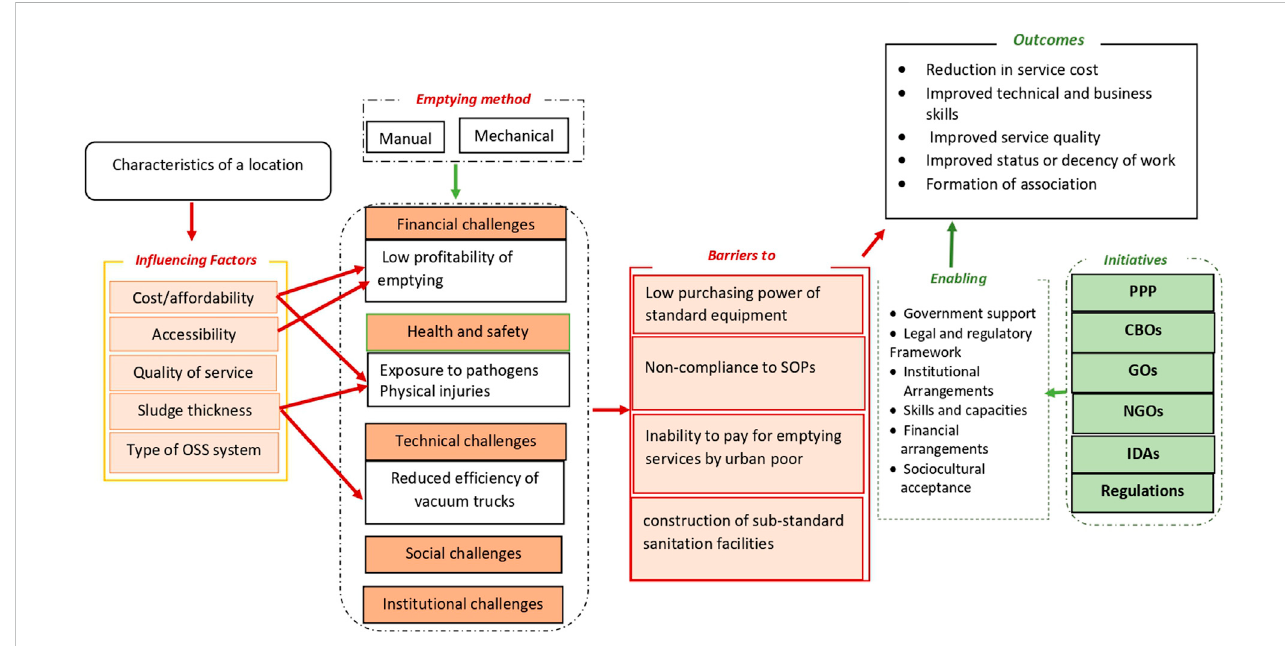
FIGURE 6 Relationship between factors in fl uencing emptying methods, challenges faced by emptiers and improvement initiatives in FS emptying business.